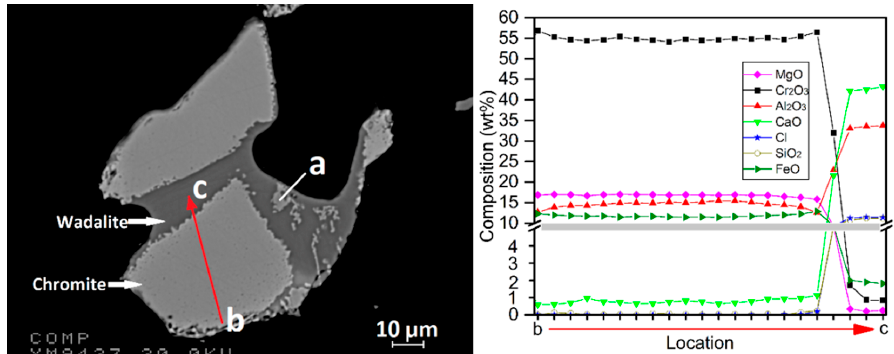
Figure 14. BSE image of the product from the TG-DSC-MS test showing the presence of wadalite and the electron probe microanalysis (EPMA) line scan along the arrow b → c.